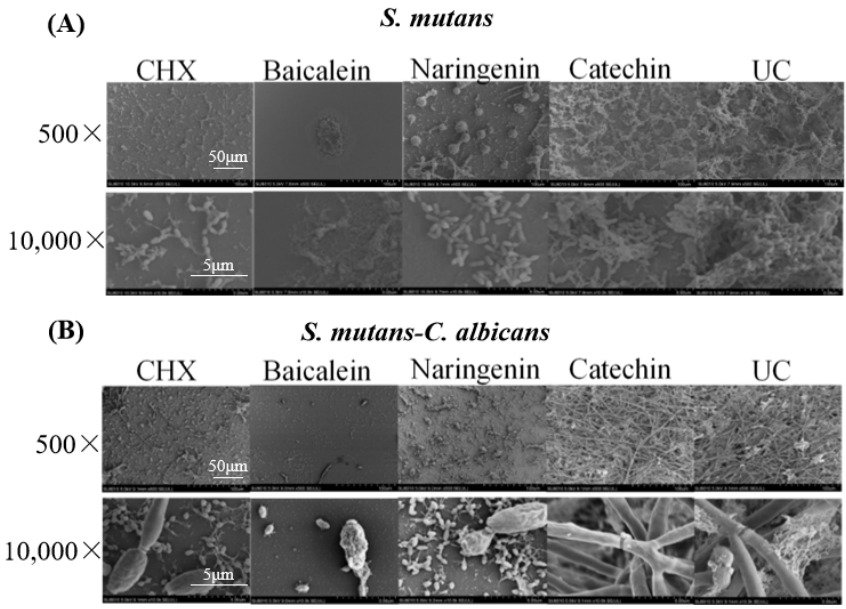
Figure 2. SEM observation of ( A ) S. mutans and ( B ) S. mutans-C. albicans biofilms after flavonoids or CHX treatment.